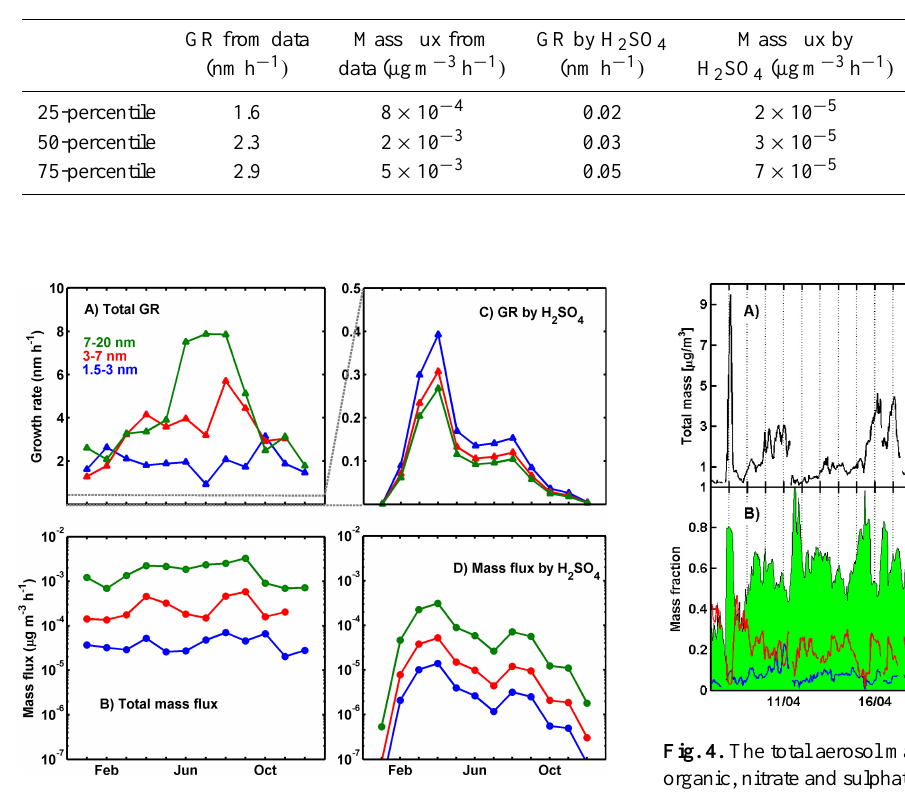
Fig. 3. Seasonal distribution of nucleation mode diameter growth rates (GR) and mass fluxes in 2003–2007. Median GRs (A) and mass fluxes (B) to 1.5–3, 3–7 and 7–20nm particles as determined from size distribution data. Median GRs (C) and mass fluxes (D) to nucleation mode aerosol as calculated from estimated ambient sul- furic acid concentration.